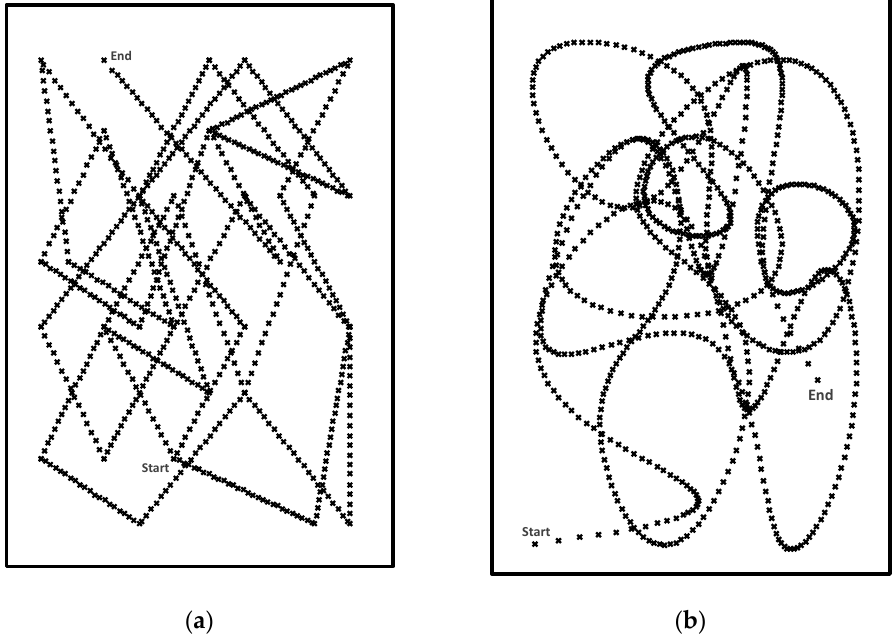
Figure 2. Samples of the random trajectory used as a challenge during the data collection: ( a ) Lines ; and ( b ) Curves (the labels’ “start” and “end” are added for the clarity of illustration only).